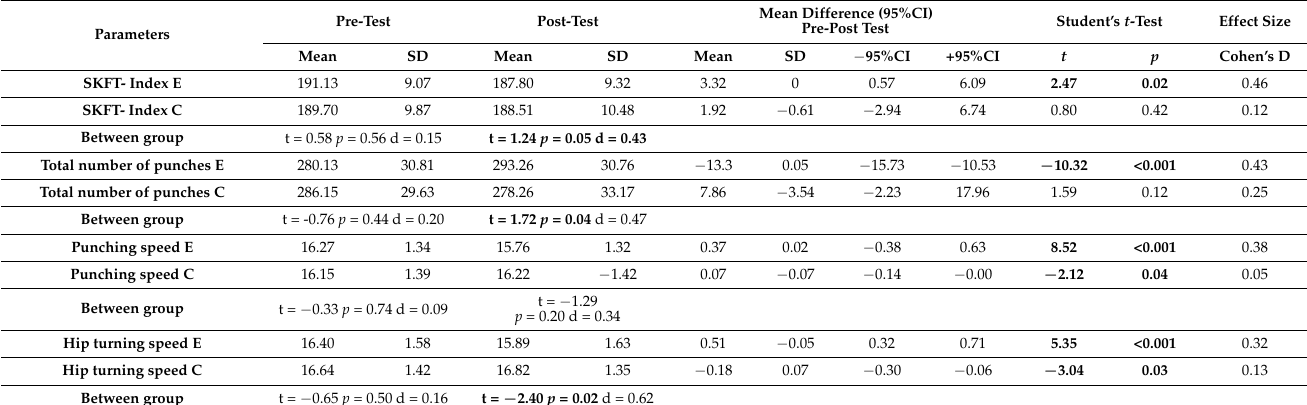
Table 4. Special physical fitness of the participants before and after the